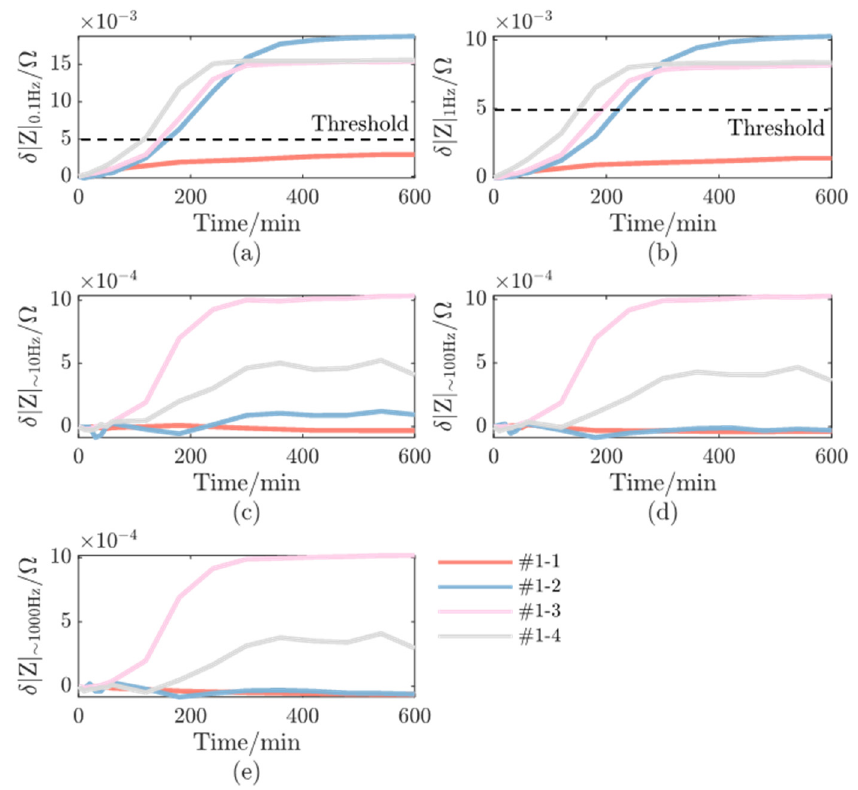
Figure 6. The electrochemical impedance changes δ | Z | of experiment group1 at ( a ) 0.1 Hz; ( b ) 1 Hz; ( c ) around 10 Hz; ( d ) around 100 Hz; ( e ) around 1000 Hz.